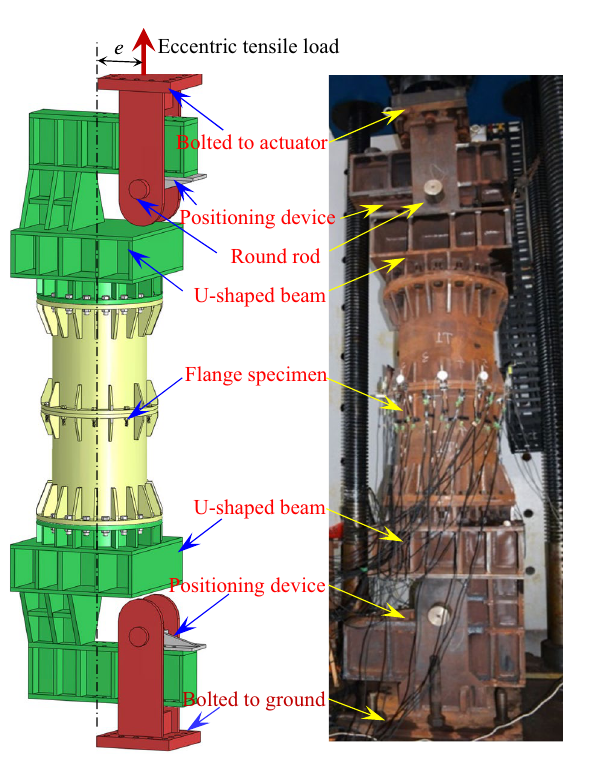
Figure 4. Experimental